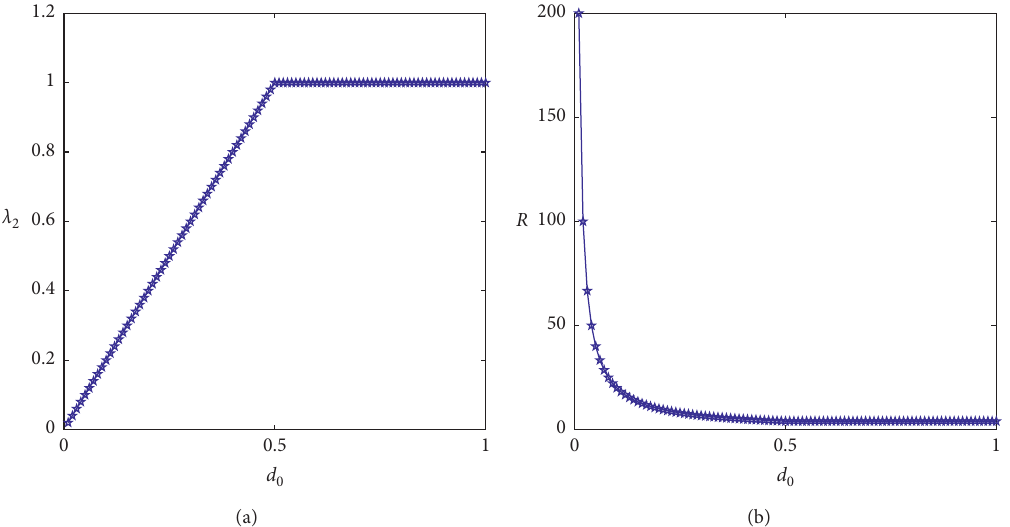
Figure 5: When N is odd, the synchronizability of Network I changes with the interlayer coupling strength d changes with d ( d changes from 0.01 to 1); (b) R changes with d 0 0